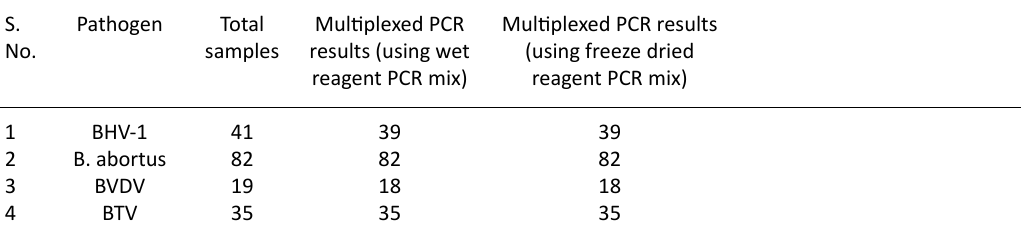
Table 3. Analogy between the freeze-dried reagent and wet reagent multiplexed PCR reaction mixtures